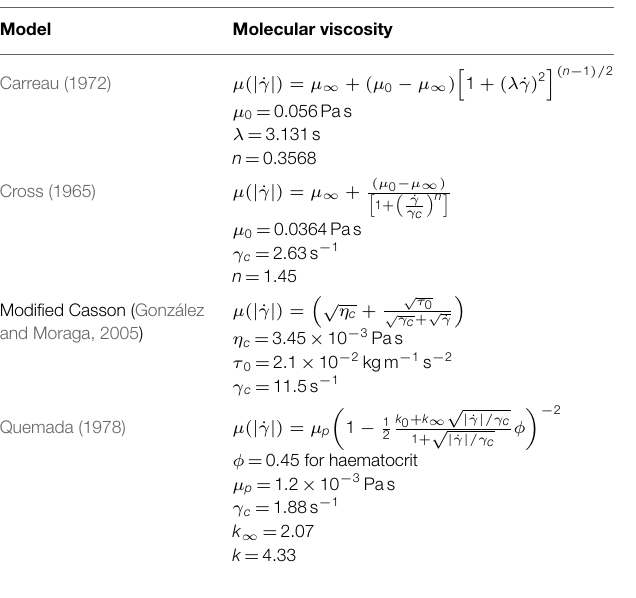
TABLE 1 | Constitutive equations of non-Newtonian models.